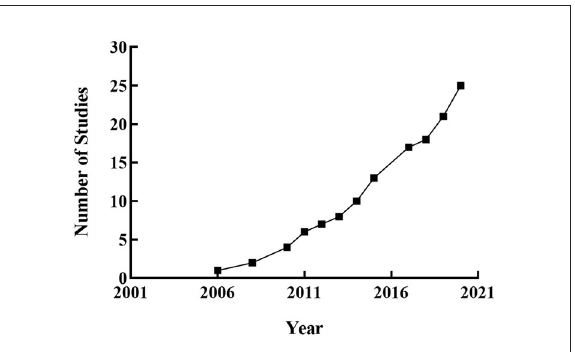
FIGURE2 The trend in the number of reviewed studies from 2001 to 2021.